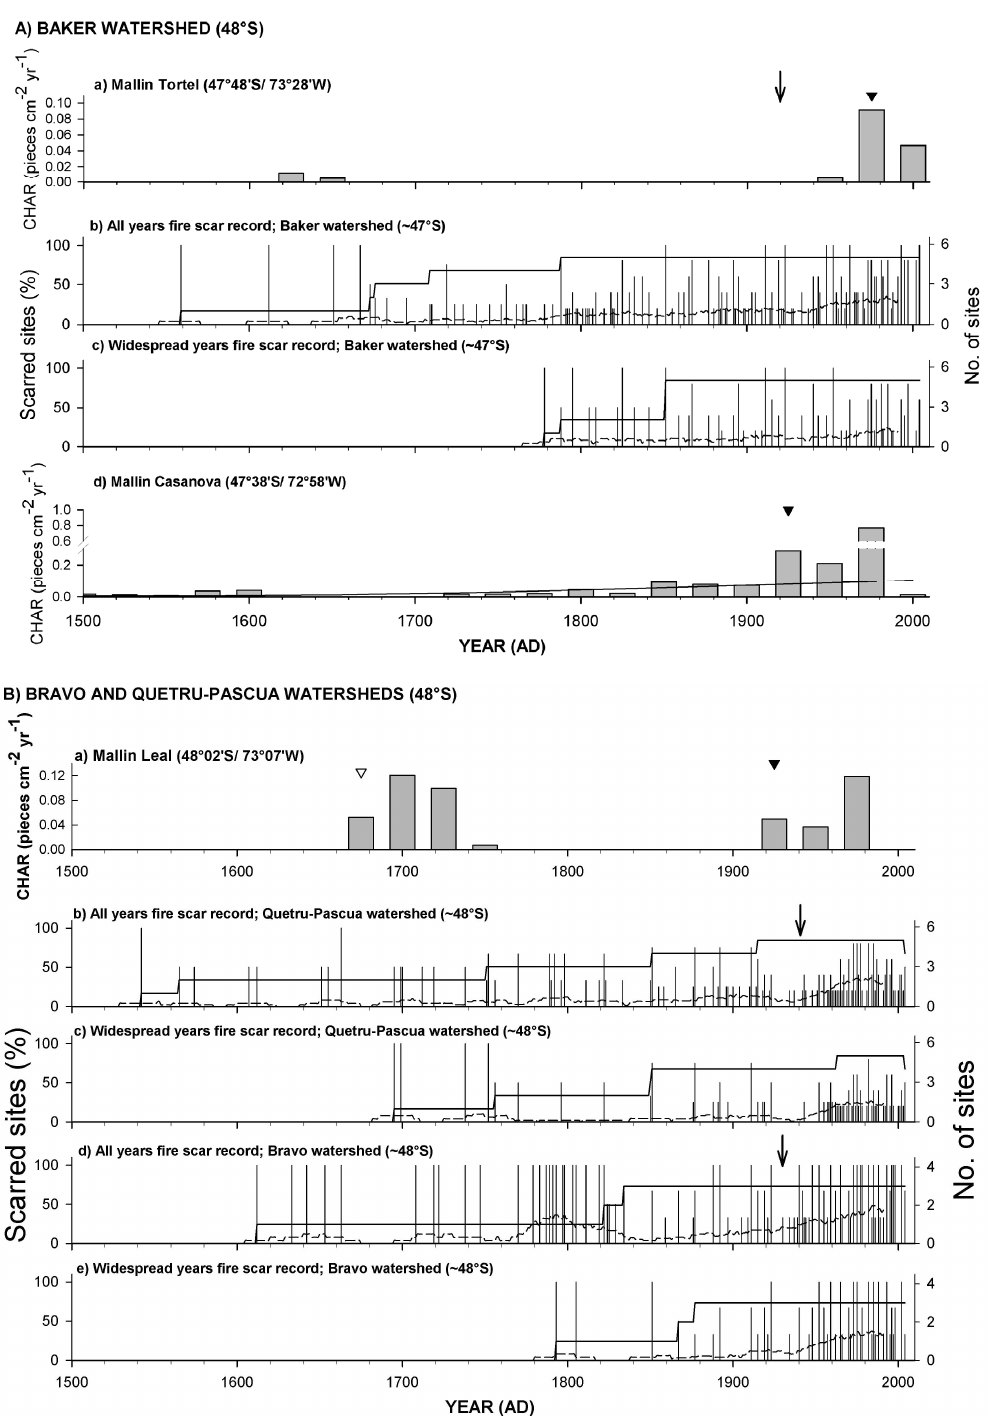
Fig. 5. Paired fire history based on fire scar and CHAR peaks in (a) the Baker watershed and (b) the Bravo and Quetru-Pascua watersheds. Fire scar indices for all fire and widespread fire years are presented by watershed. All fire years in the composite of each sample area are defined as (minimum ≥ 1 scarred tree per site). Widespread fire years in the composite of each sample area are defined as (minimum of ≥ 20% of trees scarred in each watershed including individual sites that had a minimum of 2 scarred trees). The horizontal solid and dashed line in each fire scar composite represents the number of sites scarred in each watershed and a 25-yr smoothed spline, respectively. The vertical arrow at each panel represents the Euro-Chilean period in each watershed as defined by Holz and Veblen (2011b). Note that the number of sites sampled varies among watersheds. CHAR values and symbols are defined in Fig.